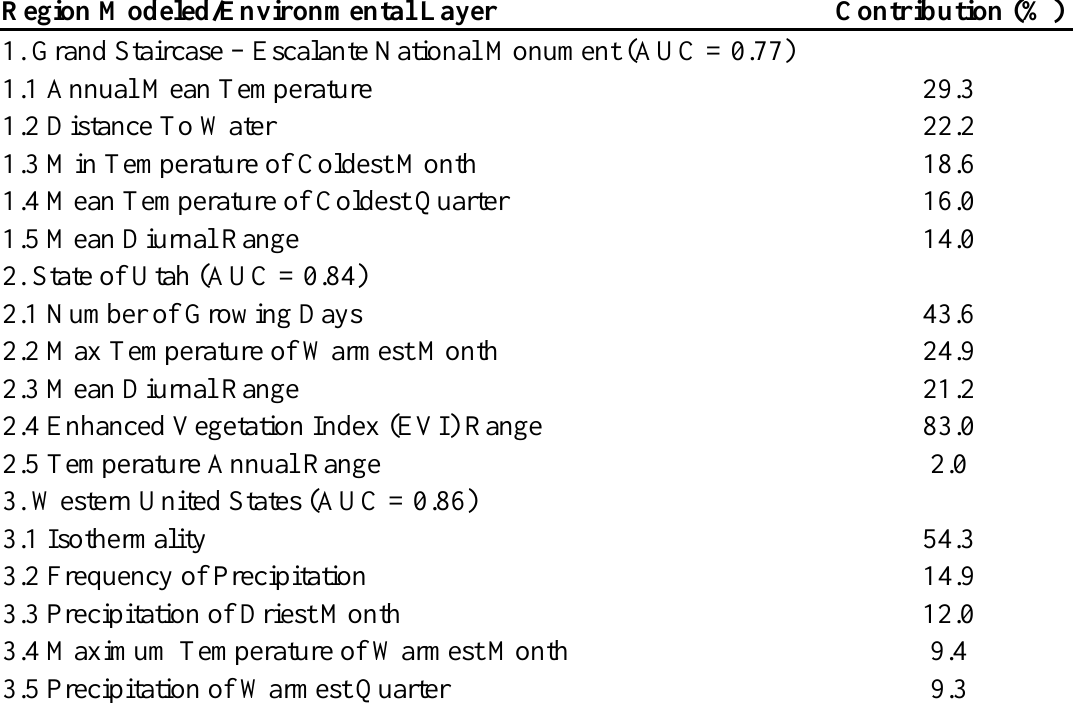
Table 1. The Area Under the Curve (AUC), and top five predictor layers for each of the three scales of models, and the percent that each environmental variable contributed to the